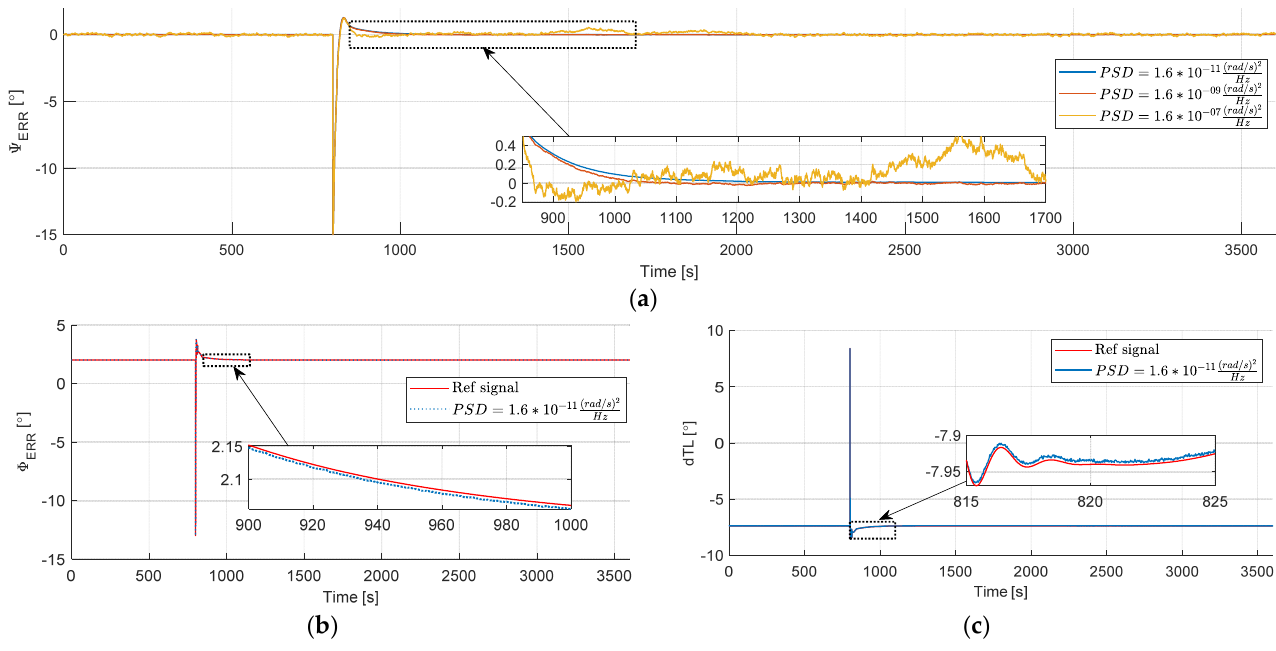
Figure 10. Influence of white noise on the elimination of sudden heading error: ( a ) Comparison of heading error; ( b ) Comparison of roll angle error; ( c ) Comparison of aileron trimmer deflection.